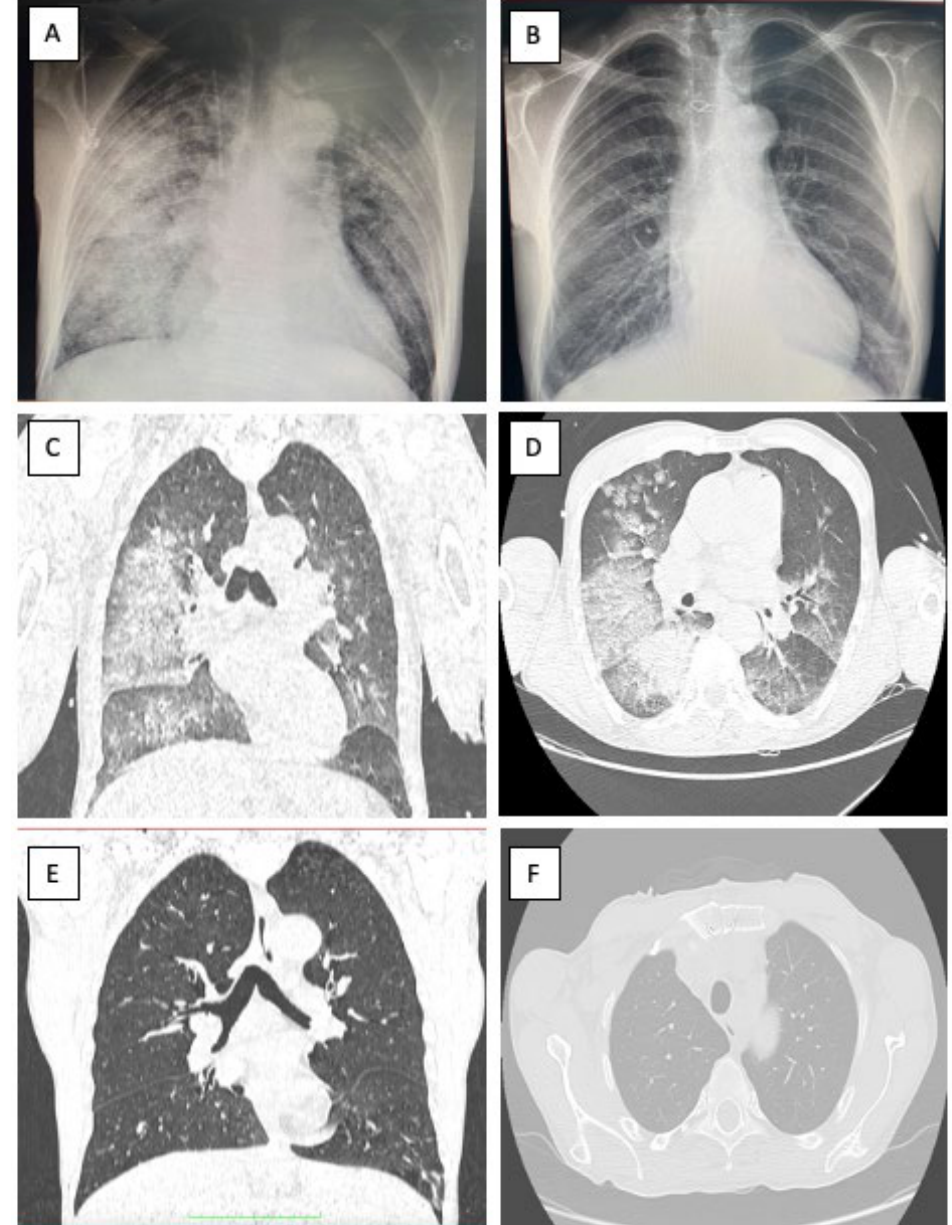
Figure 1. ( A ) Chest XR at presentation showing bilateral alveolar infiltrates, with both central and peripheric distribution in the inferior two-thirds of both lungs (more important on the right )—suggesting an infectious pulmonary disease; ( B ) chest XR at discharge showing resolution of pulmonary lesions; ( C , D ) computed tomography aspect of the lungs at presentation resembling multiple, bilateral areas of consolidation, with air bronchogram included and areas of ground-glass attenuation with a mainly central distribution, in the two-thirds of both pulmonary parenchyma (more significant in the right lung) suggesting an infectious pneumonia; ( E , F ) computed tomography aspect of the lungs at discharge with resolution of initial lesions.